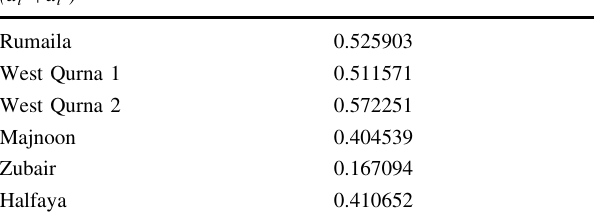
Table 14 TOPSIS—relative closeness to ideal solution Closeness Calculating the relative closeness to the ideal solution: C* = d i ? /